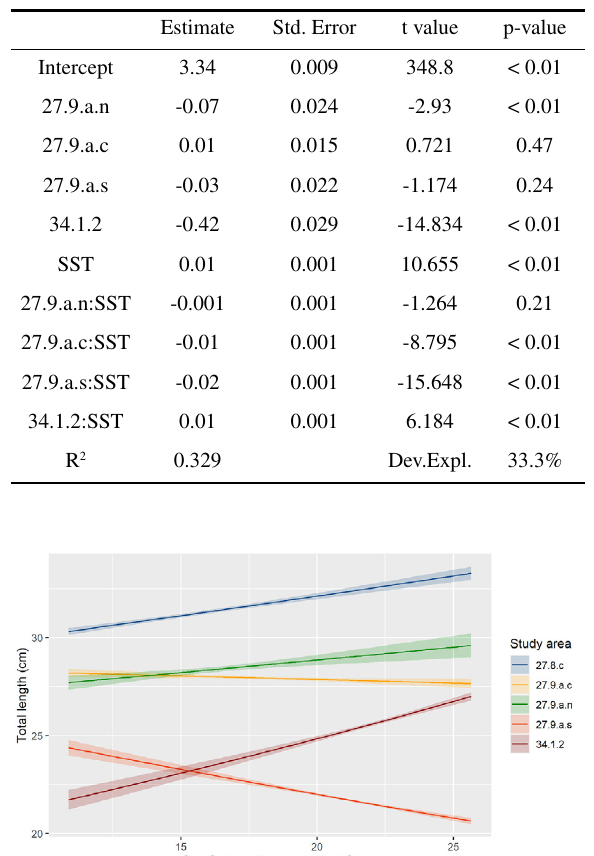
Table 4. – Parameters and coefficients of the total length model. 34.1.2, Canary Islands; 27.9.a.s, Gulf of Cadiz; 27.9.a.c, W Portuguese coast;